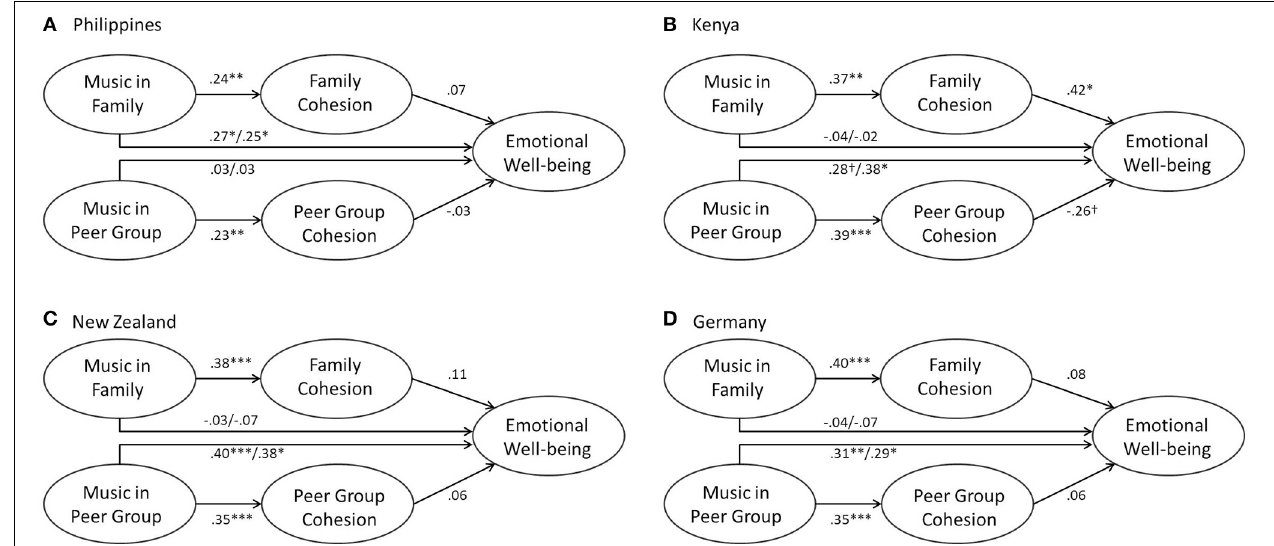
Table 4 | Model fit. χ 2 df CFI TLI RMSEA(CI) SRMR